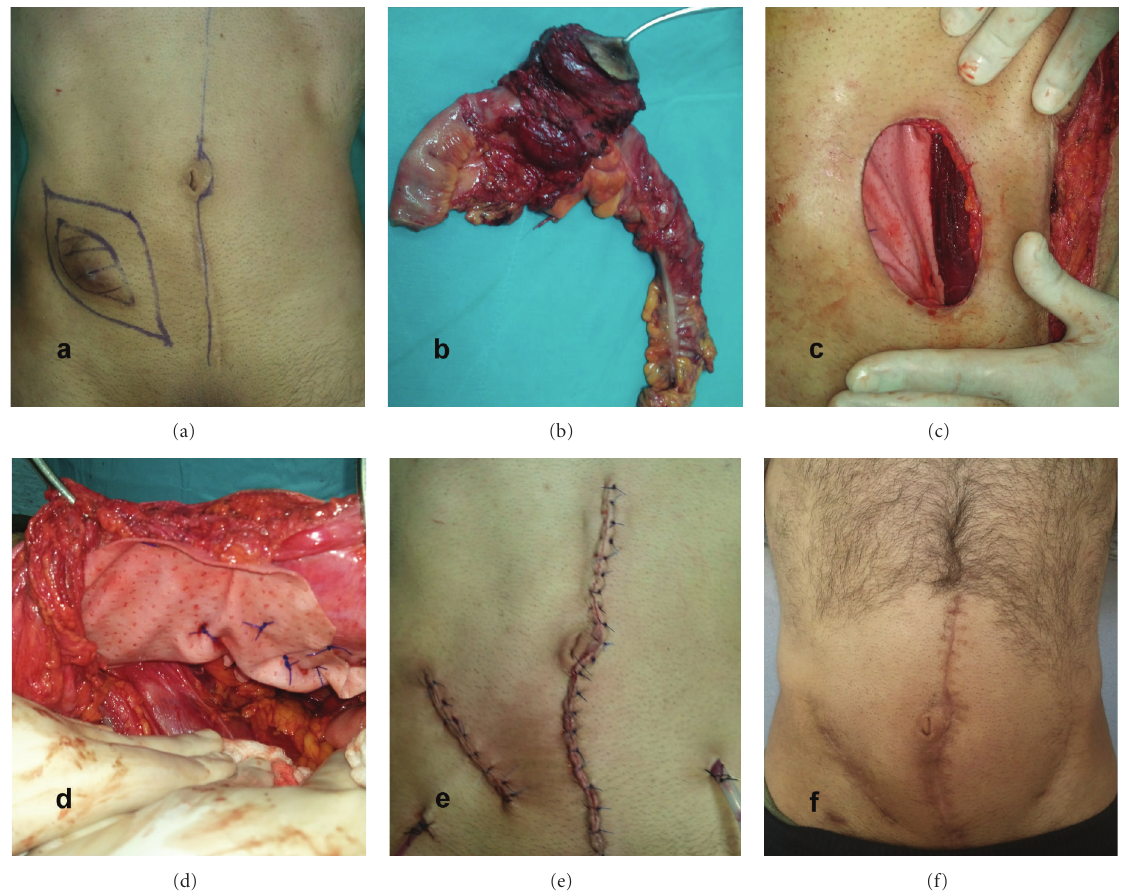
Figure 2: (a) Incisions were marked before surgery. (b) En-bloc resection material after extended right hemicolectomy. (c) Mesh applied to cover the abdominal wall defect, external view. (d) The mesh was secured with interrupted polypropylene sutures from inside. (e) The surgery has been completed and the skin closed. (f) Late postoperative view of the